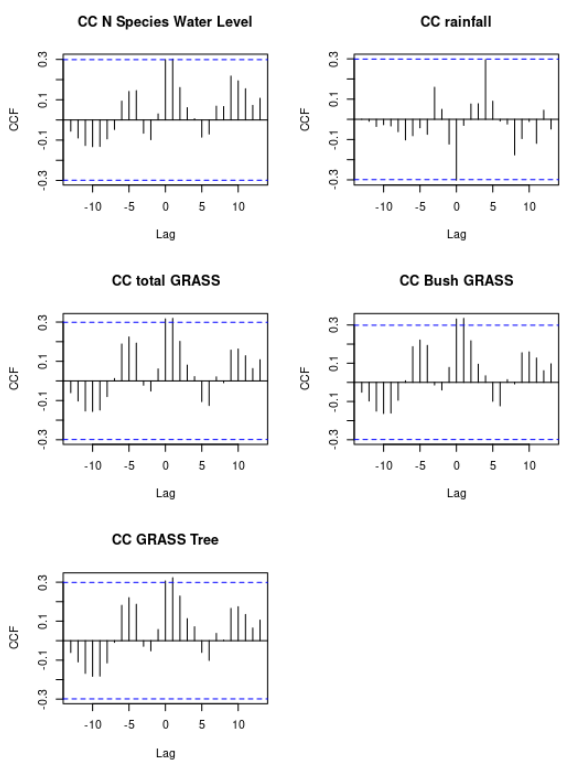
Figure 5. Cross correlation functions (CCF) between the species richness and only the significant covariates: rainfall, water level and the results of inundated areas calculated with simulations. Lags are expressed as days, the blue dashed lines are referent to a significance